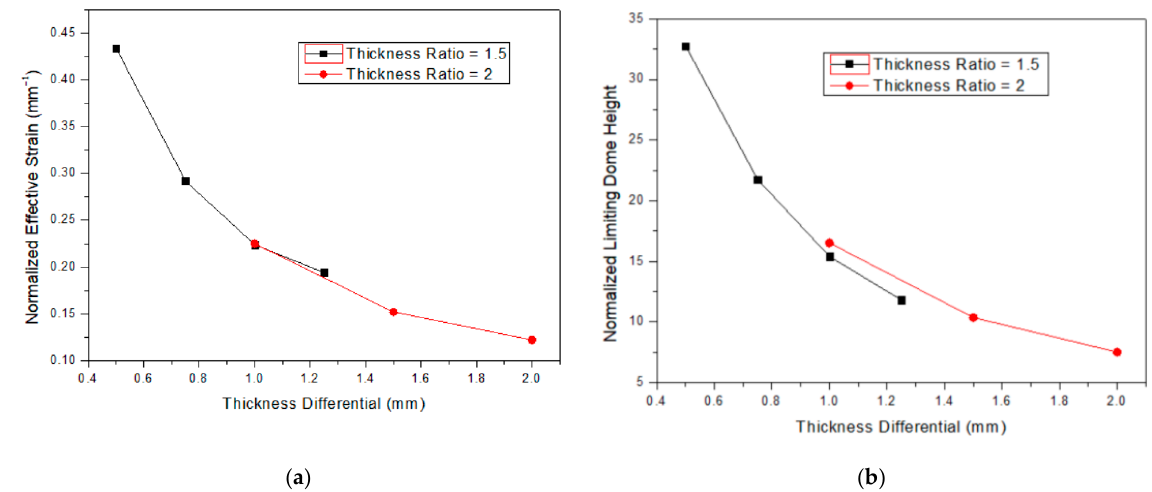
Figure 7. ( a ) Relationship between the thickness differential and normalized equivalent plastic strain; ( b ) relationship between the thickness differential and limiting dome height.